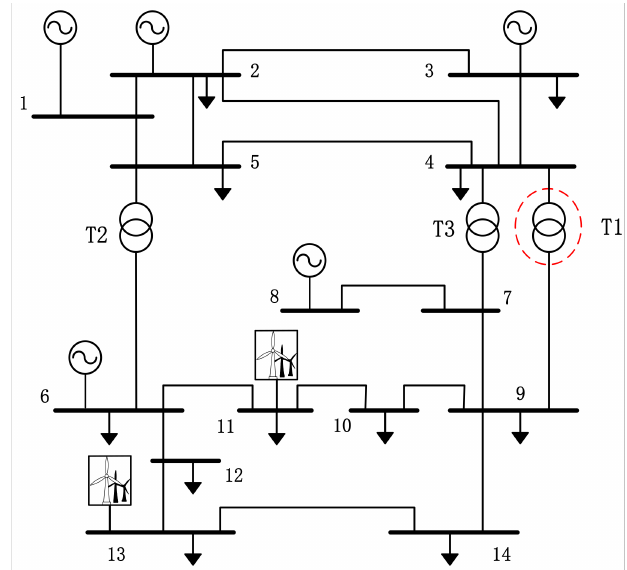
Figure 3. System structure diagram.